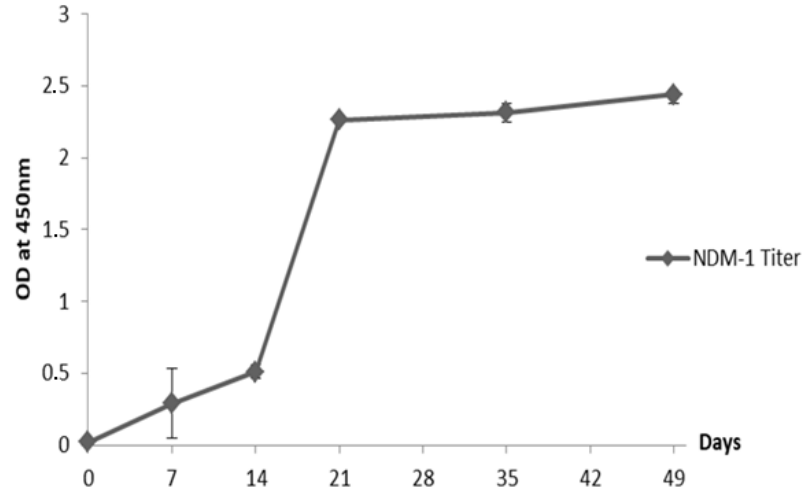
Reactivity of immune serum (1:5000) was tested by ELISA using New Delhi Metallo- β -lactamase-1 (NDM-1) at a concentration of 1 µ g / mL. The absorbance values were measured at 450 nm. Error bars represent standard deviation.